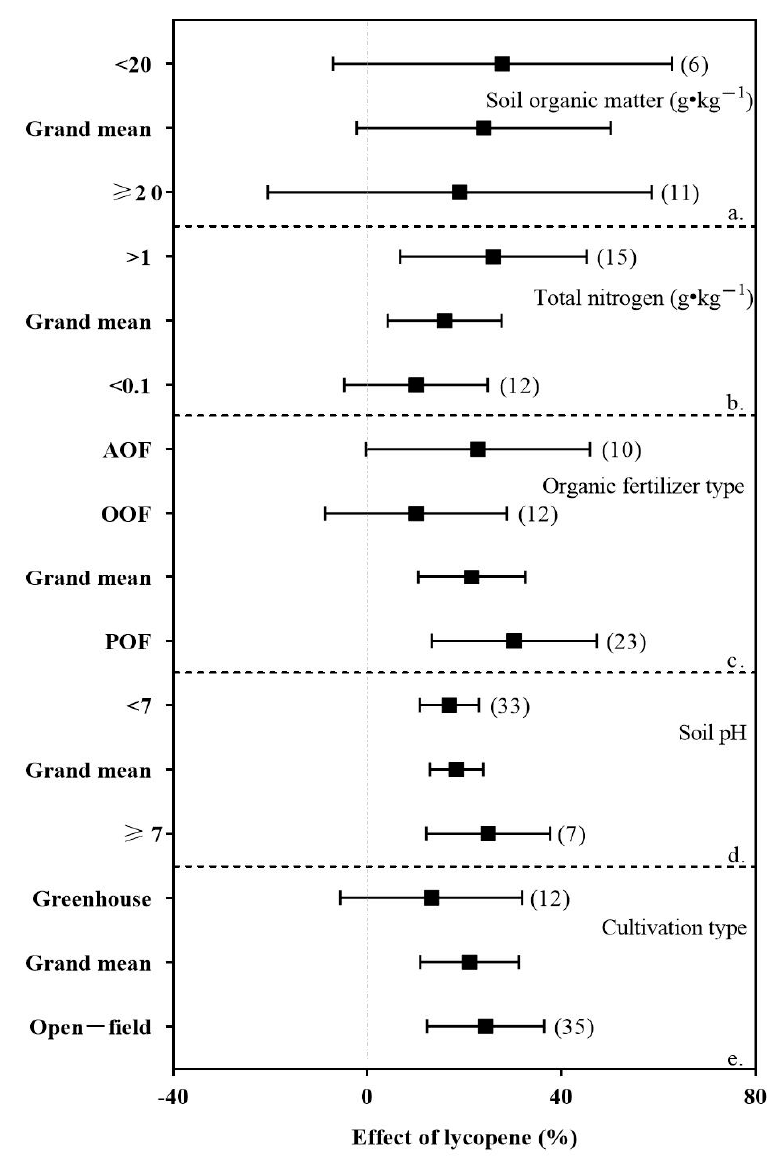
Figure 8. Organic fertilizers combined with soil organic matter ( a ), total soil nitrogen ( b ), type of organic fertilizers ( c ), soil pH ( d ), and cultivation type ( e ) on tomato lycopene percentage changes. Points represent the mean effect, while bars represent 95% confidence intervals. The numbers on the right side of the confidence intervals represent the sample sizes. AOF, animal organic fertilizer; MOF, mixed animal-and-plant organic fertilizer; POF, plant organic fertilizer; OOF, other organic fertilizer.